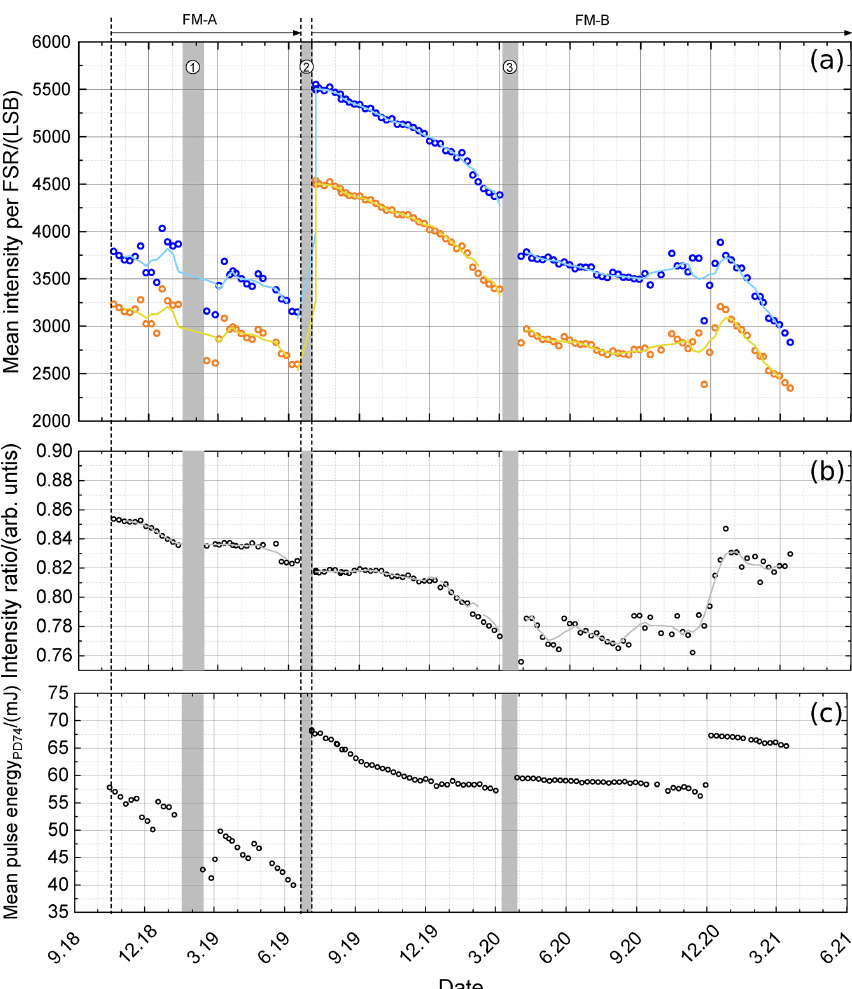
Figure 7. (a) Mean intensity per FSR of the direct channel (blue circles) and the reflected channel (orange circles), derived by fitting Eqs. (9) and (11) to the ISR data sets obtained from 10 October 2018 until 15 March 2021 (see also Table 2). The corresponding moving average of five successive data points is indicated by the light-blue line and yellow line, respectively. (b) Intensity ratio ( I ref / I dir , black circles) and moving average of five successive data points (gray line). (c) Mean laser pulse energy derived from PD-74. Special time periods are indicated by gray bars (1: instrument shut off due to a GPS reboot anomaly; 2: switch from FM-A to FM-B; 3: laser CPT